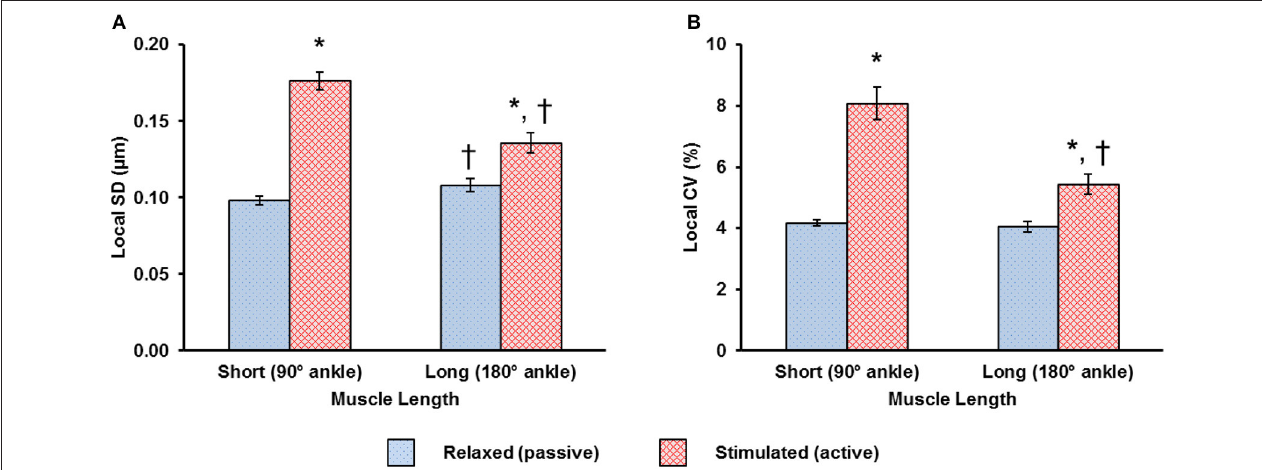
FIGURE 4 | Changes in local dispersion of sarcomere lengths (SLs) due to activation are shown using (A) the local standard deviation (SD) and, (B) the local coefficient of variation (CV), and were measured at the short and long muscle lengths. Muscle activation resulted in increased dispersion in SLs. The increase in dispersion was more pronounced for sarcomeres at the short compared to the long muscle length. *Indicates significant differences in local SD or in local CV compared with sarcomeres in the relaxed muscle at either the short or the long length ( p < 0.01). † Indicates significant differences in local SD or in local CV compared with sarcomeres in either the relaxed or the activated muscle at the short length ( p <